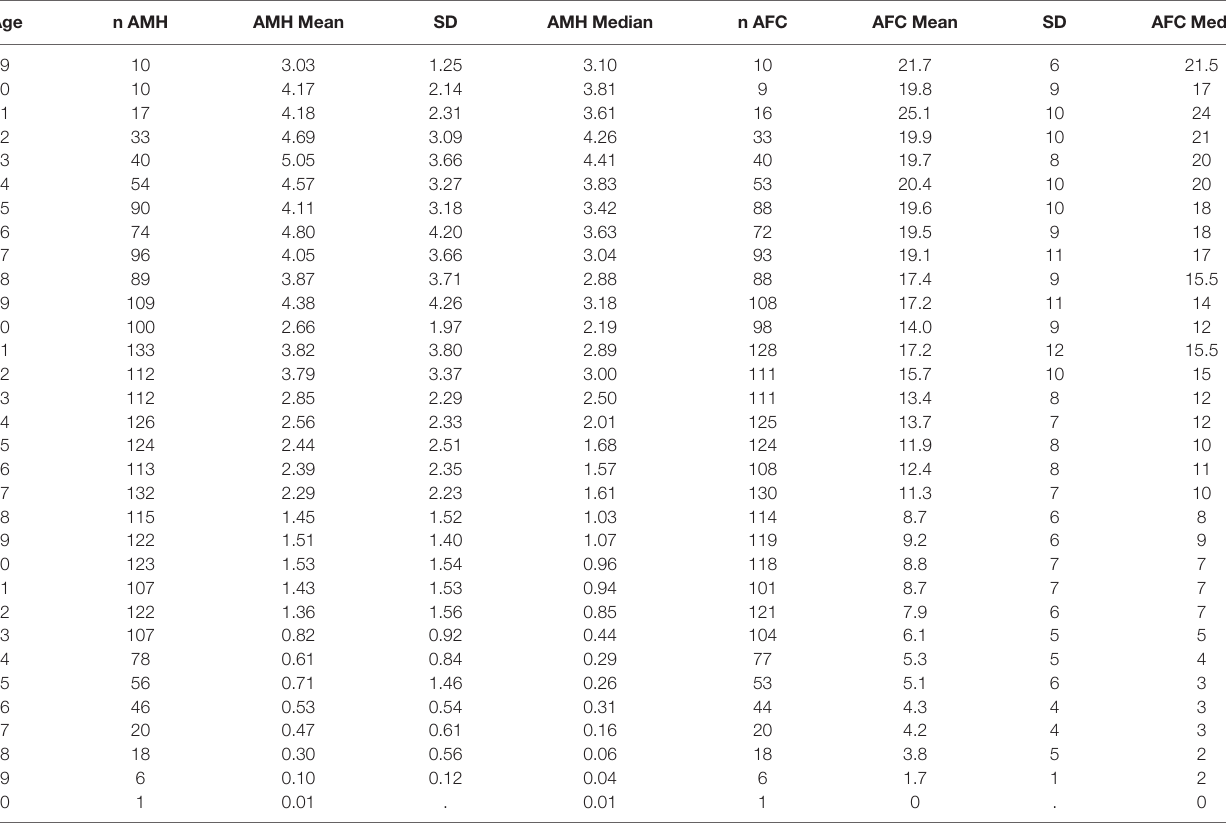
TABLE 2 | Single-age speci fi c AMH mean with standard deviation (SD) and median values obtained by Elecsys AMH immunoassay, and single-age speci fi c AFC mean with standard deviation (SD) and median.